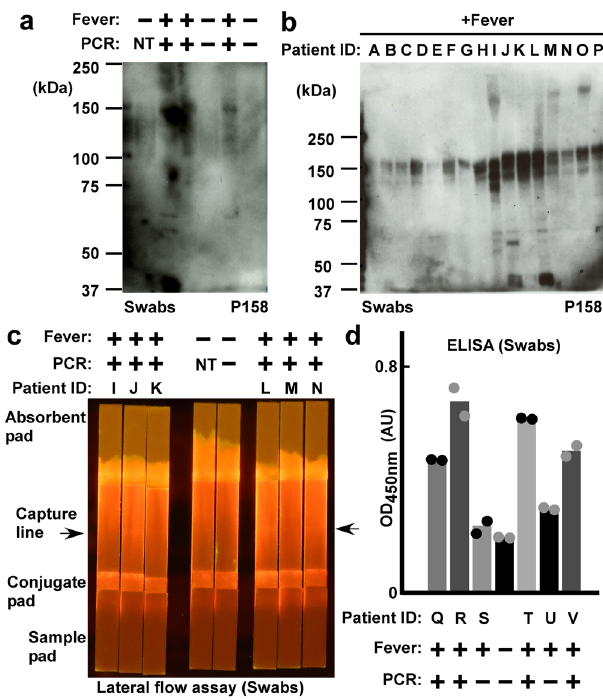
Fig. 4 Nanobodies for immune assays testing nasal swab specimens. a P158 nanobody-based western blotting of nasal swab specimens. Patients with fever ( + ) and con fi rmed to be positive for SARS-CoV-2 by PCR test ( + ); healthy volunteers with no fever ( – ) and negative by PCR test ( – ) were compared (NT: not tested). b P158 nanobody-based western blotting assays of swabs from emergency fever patients. A to D and I to P were con fi rmed positive for SARS-CoV-2 by PCR test; E to H were not con fi rmed to be positive by the PCR test. c P158 nanobody-lined lateral fl ow assays of swabs from emergency fever patients. Control and patient samples are the same as those in a and b , respectively. d P158 nanobody-captured ELISA. Means of detection signals of the nasal swab specimens are shown. Data are representative of one independent experiment out of two biologically independent